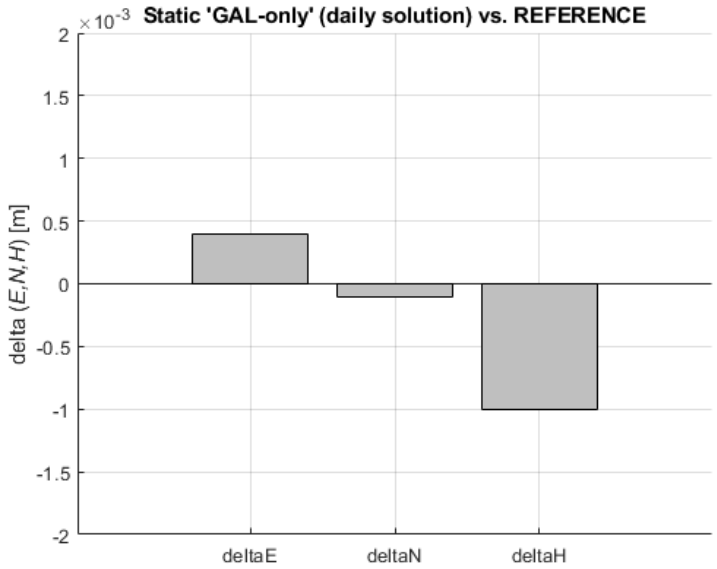
Figure 5. Coordinate differences (delta E, delta N, delta H) of static ‘GAL-only’ (daily solution)– REFERENCE.